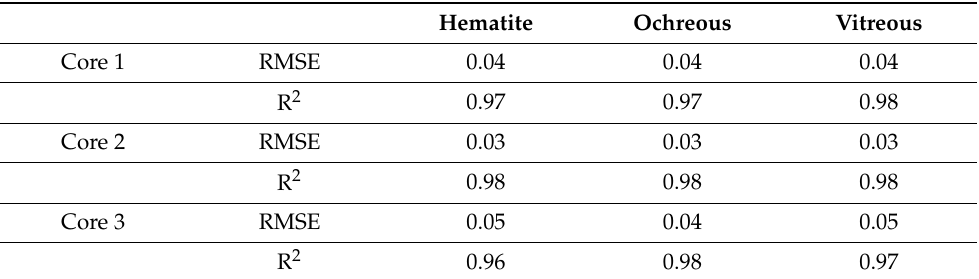
Table 5. The RMSE modeling error and R 2 for each of the drillcore in question when 20% of the RFR input features and known mixing ratios are held out for